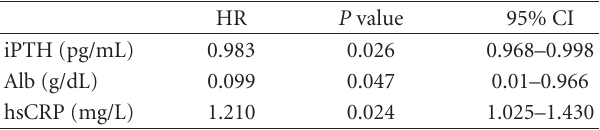
Table 3: Multivariate analyses of characteristics associated with APD.